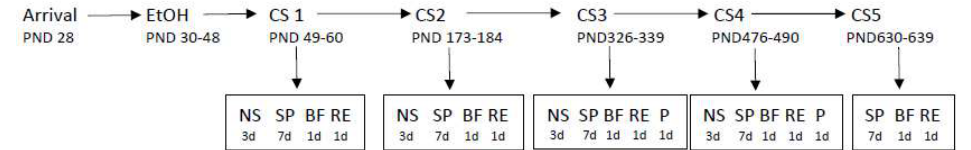
Figure 1. Experimental Timeline. Subjects arrived in the colony and were treated with ethanol every other day for 20 days followed by five unique cognitive testing sessions for the next 20 months. PND denotes age (post-natal day), CS denotes cognitive session, NS denotes. nonspatial learning, SP denotes spatial learning, BF denotes behavioral flexibility test, RE denotes relearning test, P denotes probe trial. The number of days of each test is listed under the specific test. See method section for specific details of each